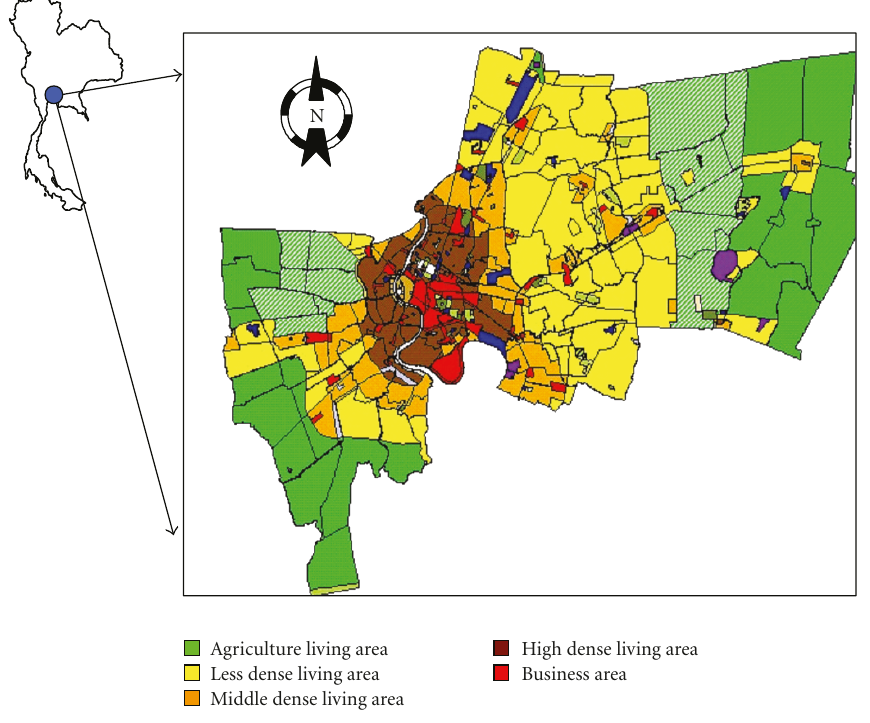
Figure 7: Land used map of Bangkok City.